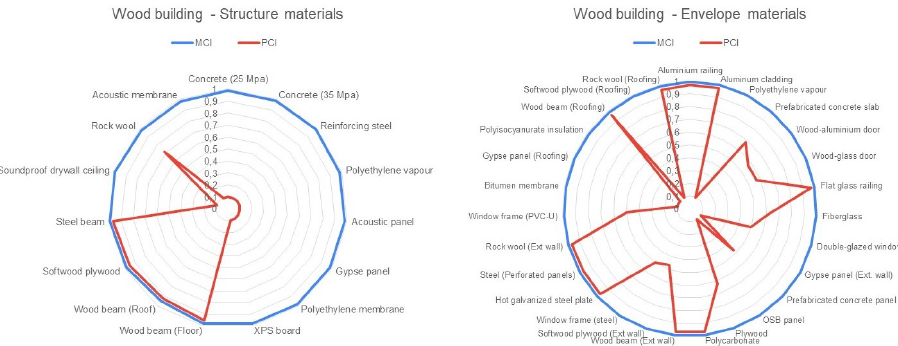
Figure 3. MCI and PCI results – Wood-framed building.